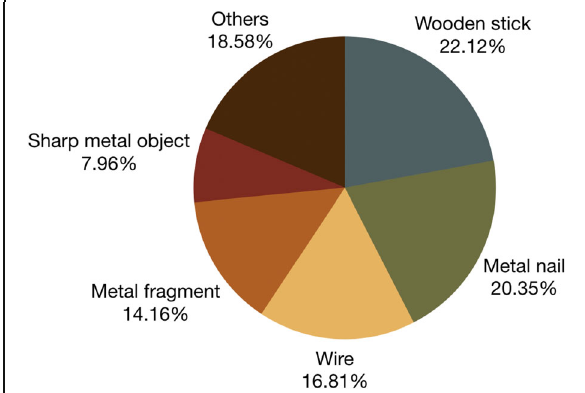
Fig. 6 Offending agents in post-traumatic endophthalmitis cases ( n = 113). Wooden sticks were the most common traumatic objects